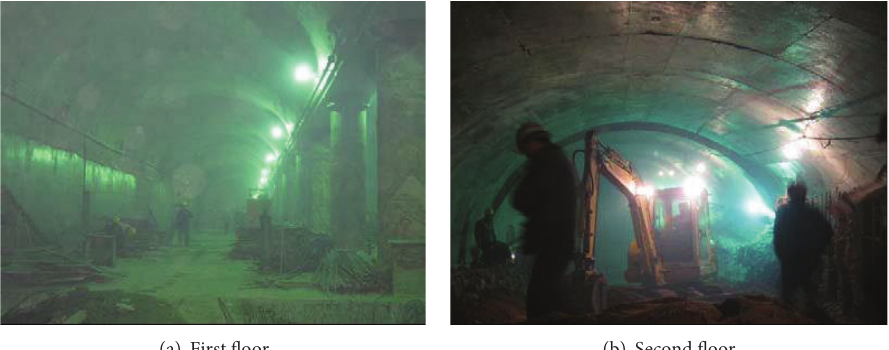
Figure 4: Photo of construction site.